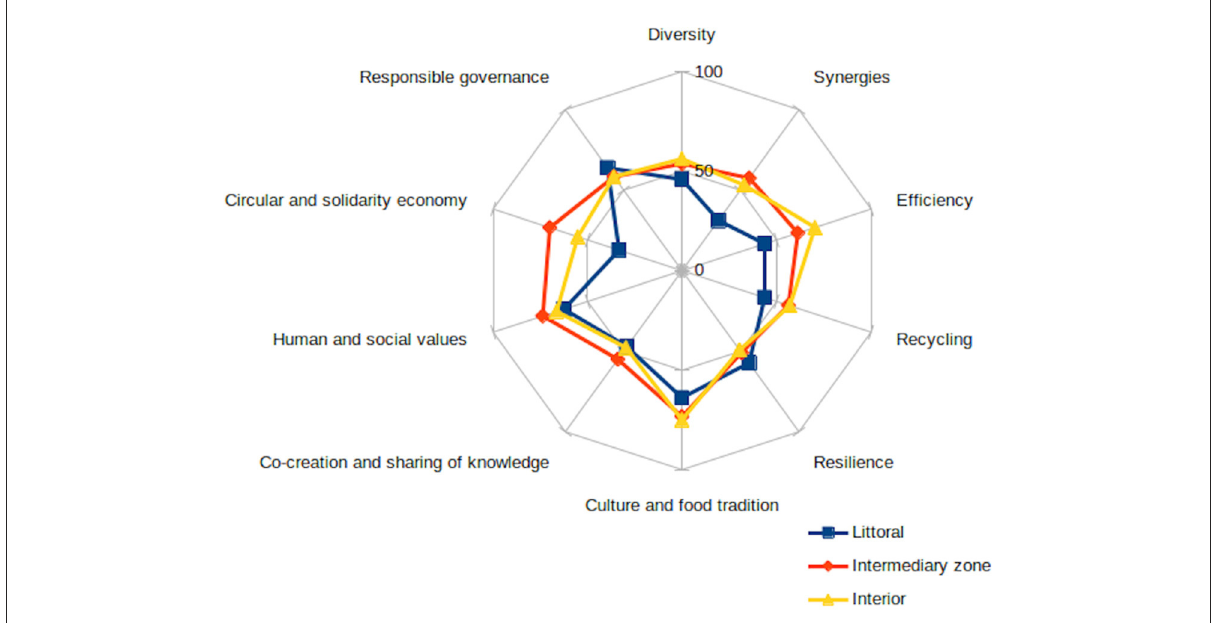
FIGURE2 Results of TAPE—Step 1 according to geographical